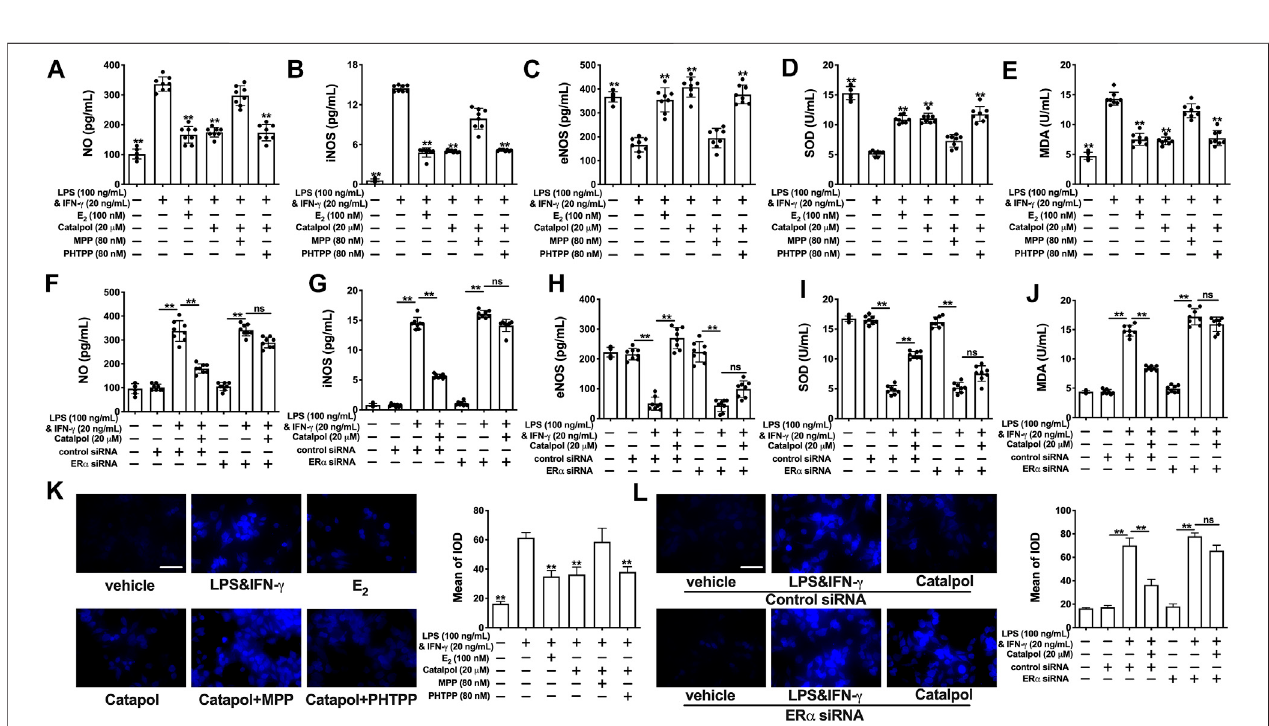
FIGURE 6 | Catalpol attenuated oxidative stress in M1 macrophages through regulating ER α . (A – C) With MPP and PHTPP, effects of catalpol on the levels of NO, iNOS and eNOS ( n (cid:2) 8); (D – E) With MPPand PHTPP, effects ofcatalpol on thelevels ofSOD and MDA ( n (cid:2) 8); (F – H) With ER α siRNA, effects ofcatalpol on the levels of NO, iNOS and eNOS ( n (cid:2) 8); (I – J) With ER α siRNA, effects of catalpol on the levels of SOD and MDA ( n (cid:2) 8); (K) With MPP and PHTPP, effect of catalpol on the level of ROS was stained by immuno fl uorescence ( n (cid:2) 3); (L) With ER α siRNA, effect of catalpol on the level of ROS was stained by immuno fl uorescence ( n (cid:2) 3). Data are expressed as mean ± SD. * p < 0.05, ** p < 0.01 vs. LPS&INF- γ group.